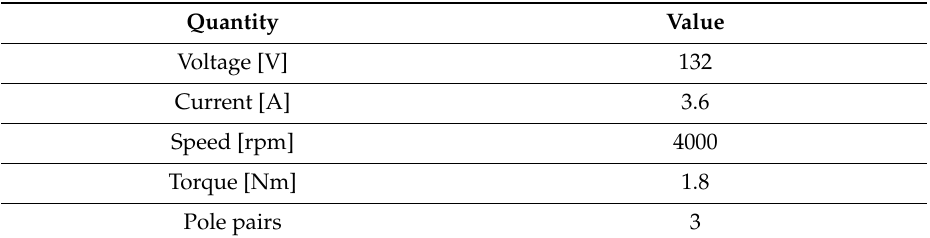
Table 6. Rated values and parameters of IPMSM under